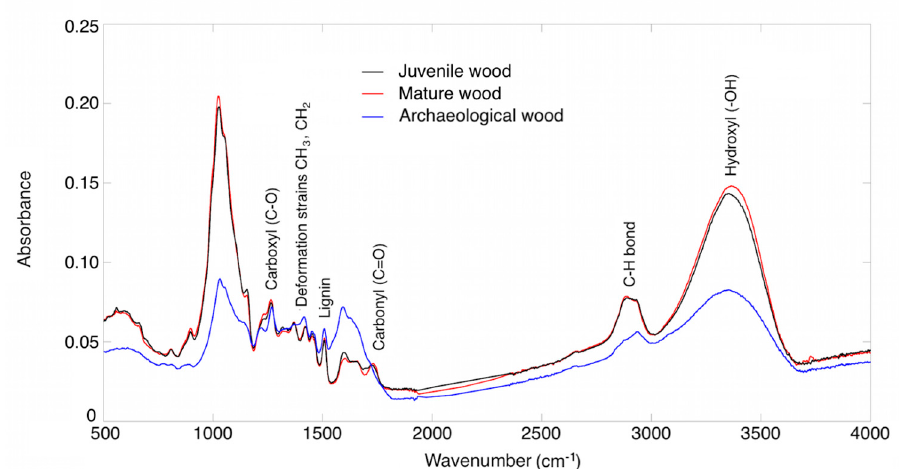
Figure 6. ATR-FTIR spectrum of juvenile, mature, and archaeological wood.